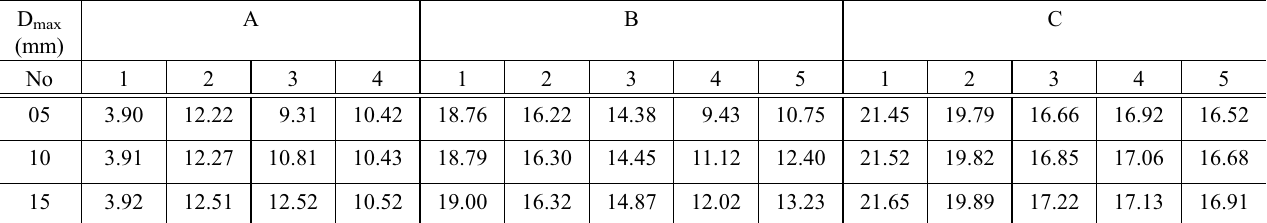
Table 7 Influence of coarse granulate dimension to the ternary concretes on the compressive strength (in MPa) after 40 freeze thaw cycles.